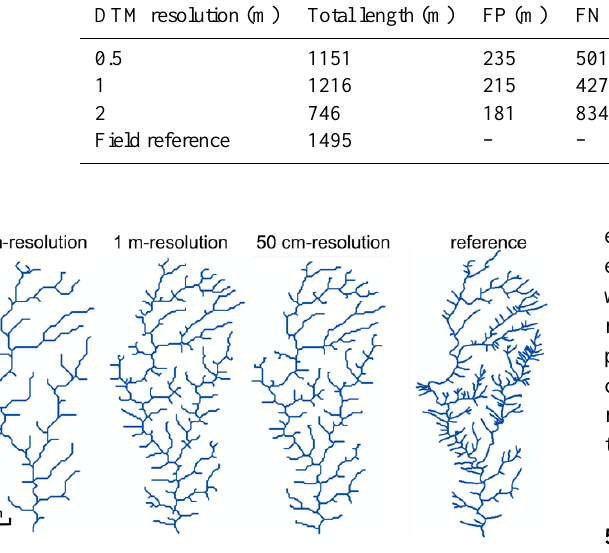
Figure 8. Results of the CI-based method applied to three different DTM resolutions 2 Fig. 8. Results of the CI-based method applied to three different DTM resolutions compared to the field reference; the Moulin catch- compared to the field reference; the Moulin catchment test area. 3 ment test